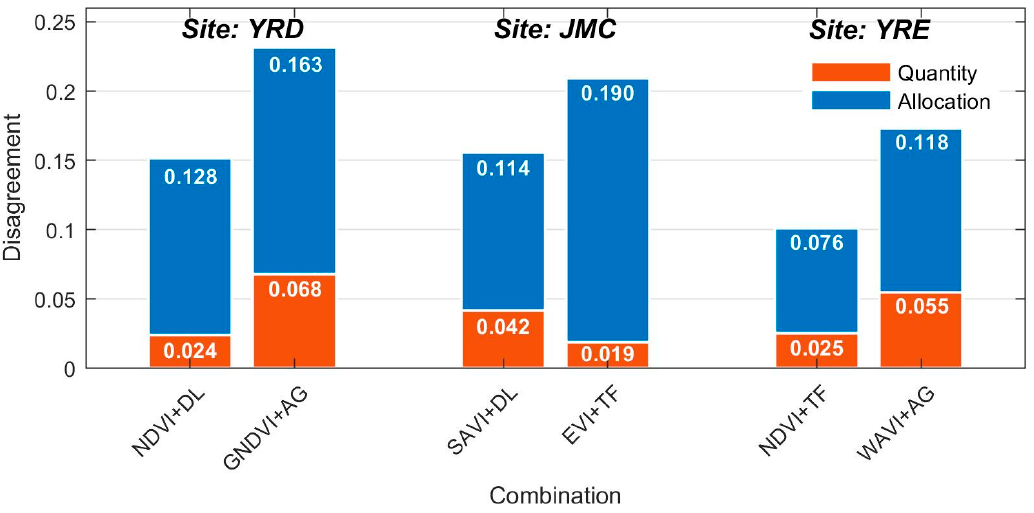
Figure 9. Quantity disagreement and allocation disagreement corresponding to the models with high and low separability for each study site.